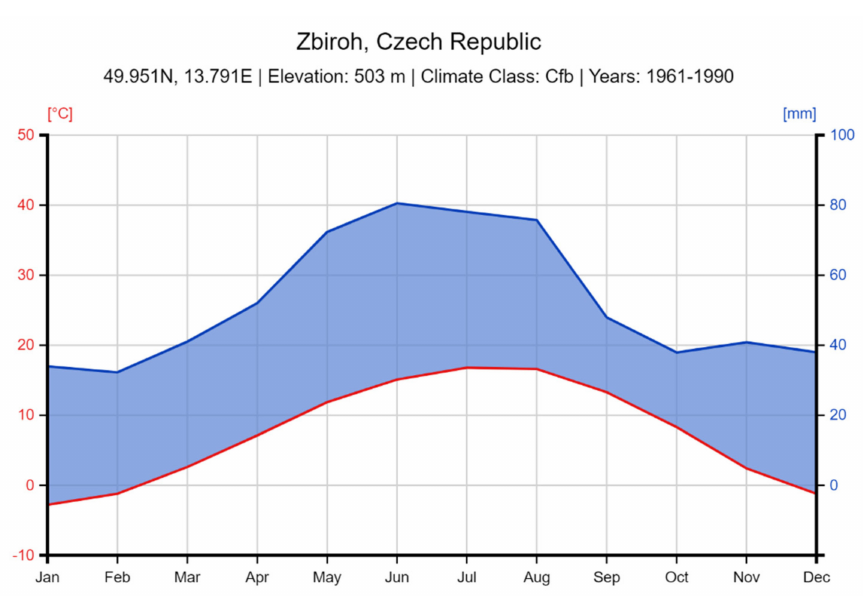
Figure 6. Climate chart of the trial Zbiroh (mean annual data for 1961–1990: temperature 7.2 ◦ C; precipitation: 586 mm). Note the quantity and seasonal distribution of precipitation with a summer maximum.